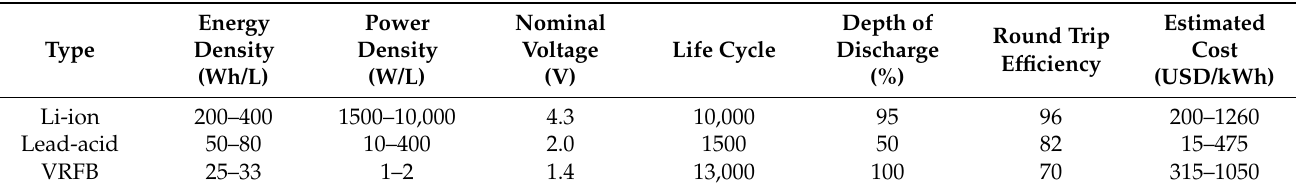
Table 1. Table of the properties of lithium-ion (LIB), lead-acid and vanadium redox flow batteries (VRFB)